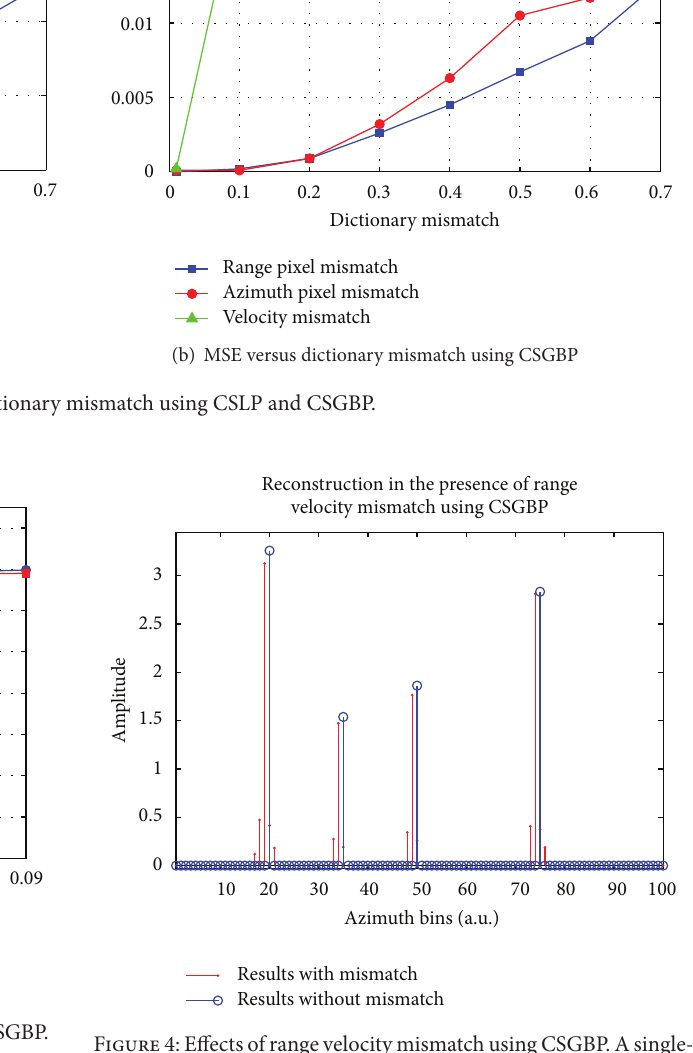
Figure 4: Effects of range velocity mismatch using CSGBP. A single- pixel shift and some side lobes can be